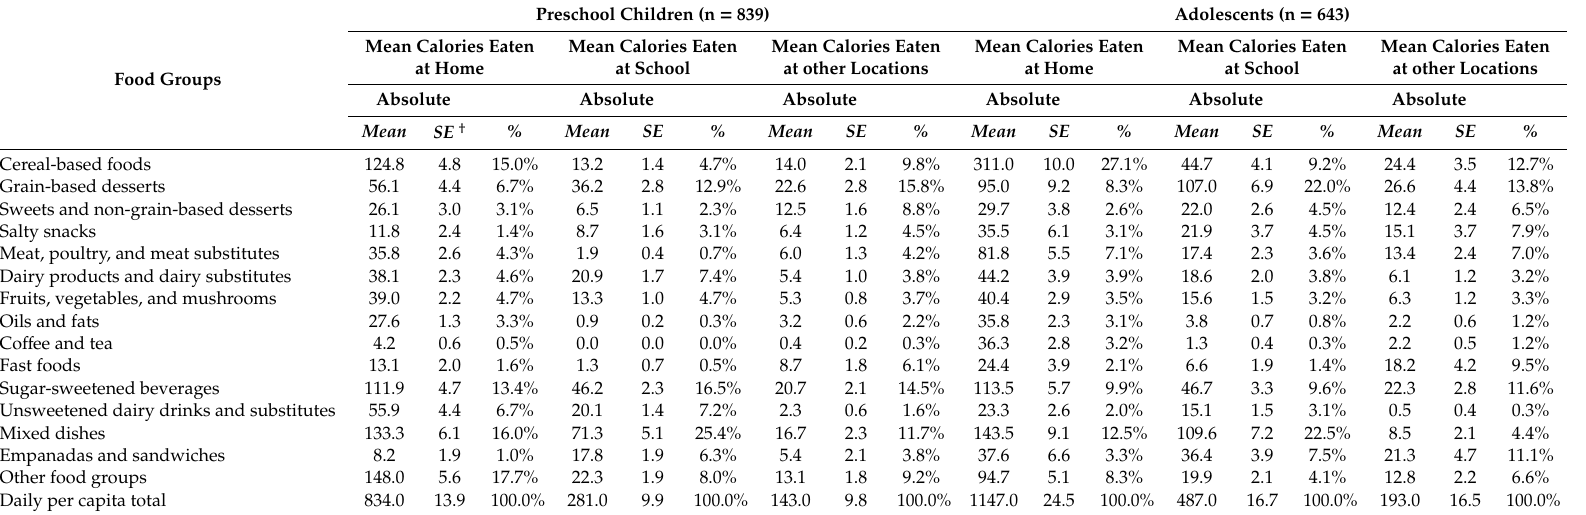
Table 5. Percentage of per capita total daily calories from food groups by eating location (home, school, other) * among low- and middle-income Chilean children and adolescents from Southeast Santiago,